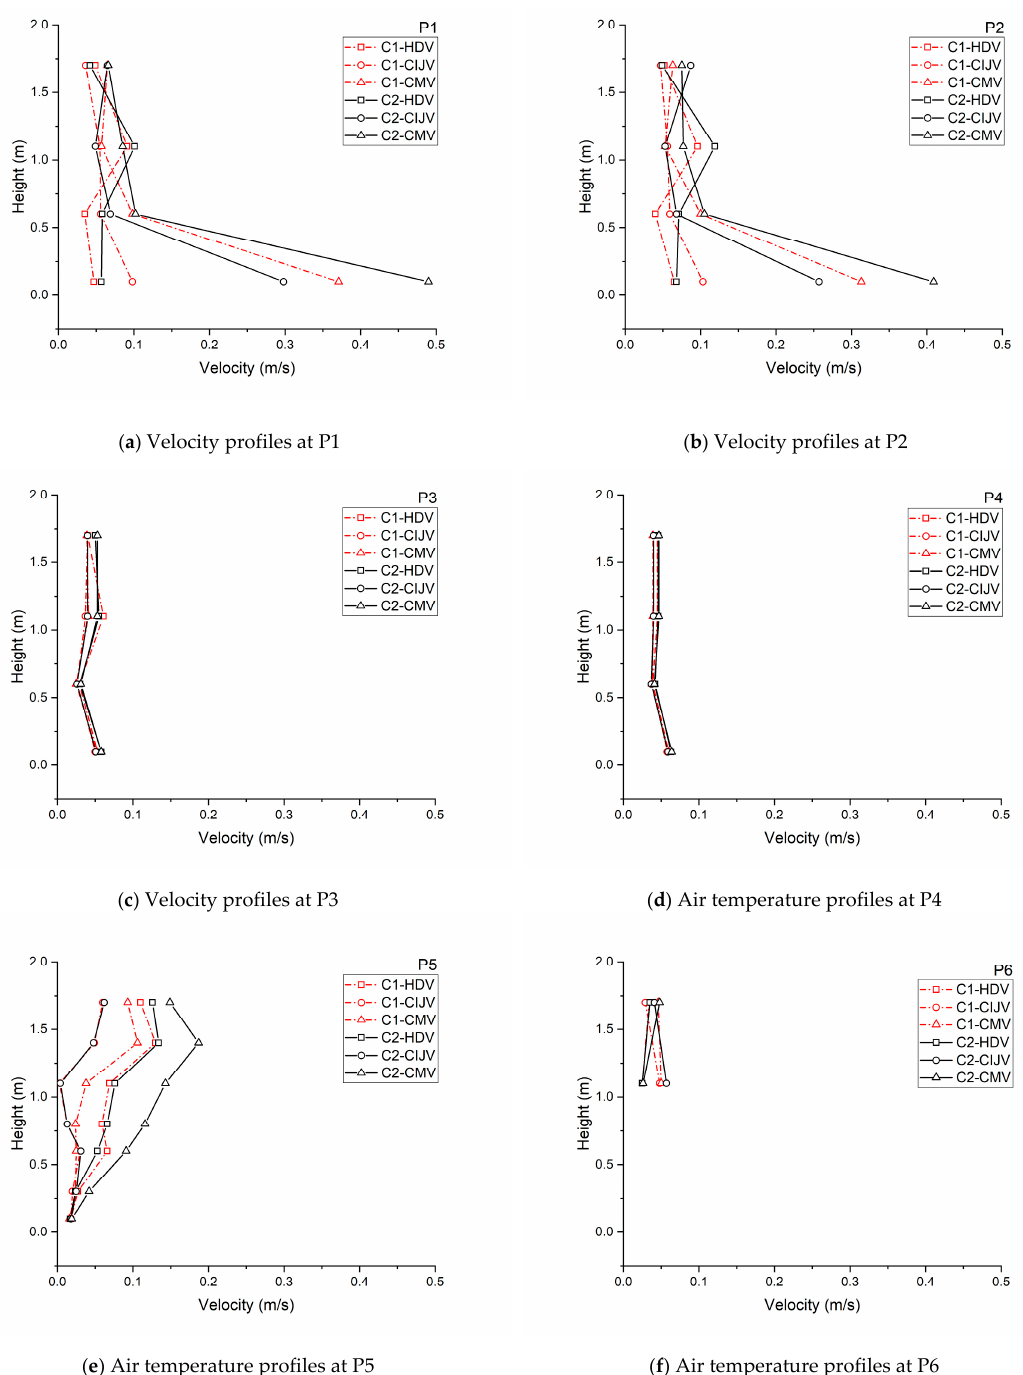
Figure 4. Velocity profiles at position P1 ( a ), P2 ( b ), P3 ( c ), P4 (d), P5 ( e ) and P6 ( f ) for all cases.